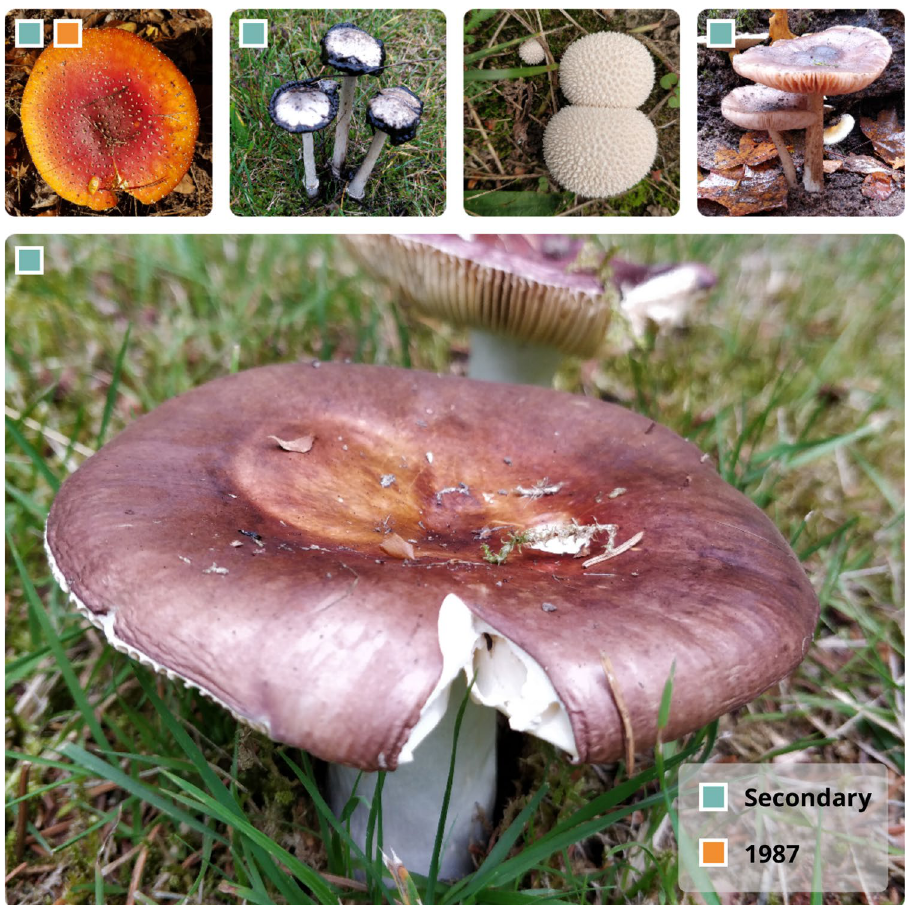
Figure 1. Annotated mushroom observations. From left to right, the annotated mushroom species are: Amanita muscaria, Coprinopsis atramentaria, Pluteus cervinus . The one image without an annotation corresponds to a species from the puffball mushroom family. Because stemless mushrooms species were excluded from the data, an identification cannot be made. The largest image is shown for a mushroom from the Russula fragilis species with the following attributes: sunken cap-shape, purple cap-color, whitegill-color, whitestem-color.